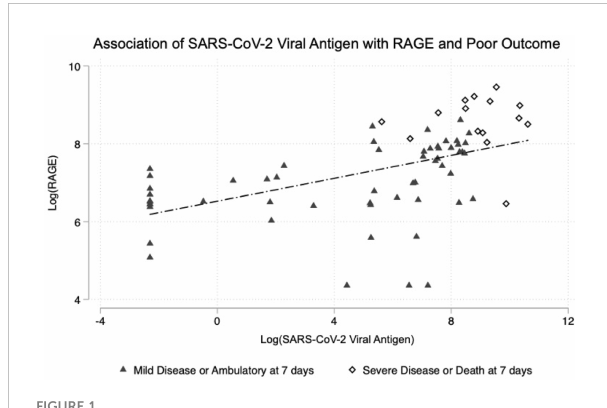
FIGURE 1 Association of SARS-CoV-2 viral antigen levels on emergency department presentation with RAGE and with subsequent clinical outcome at 7 days.